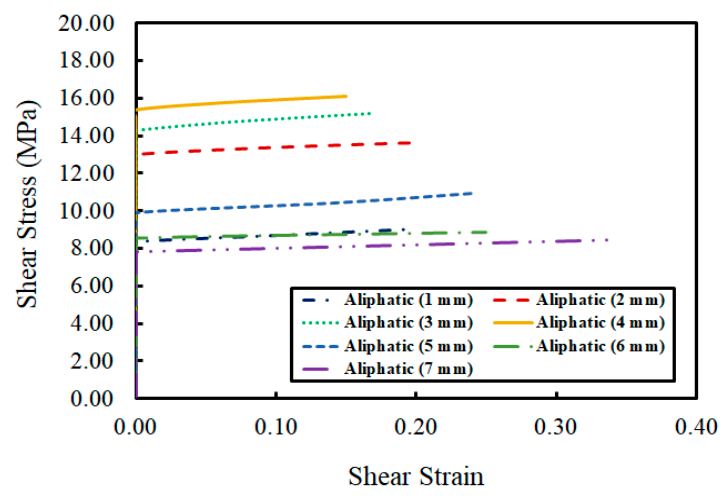
Figure 6. Relationship of shear strain to shear stress in Adhesive 1.